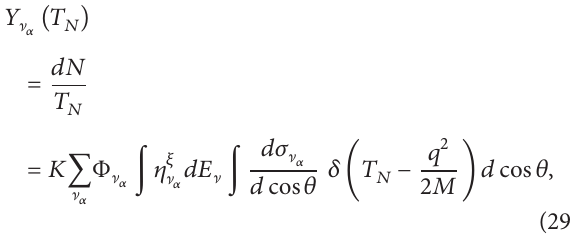
signals 𝜎 sign ] , coming out of our calculations for the adopted lab . nuclear targets are discussed